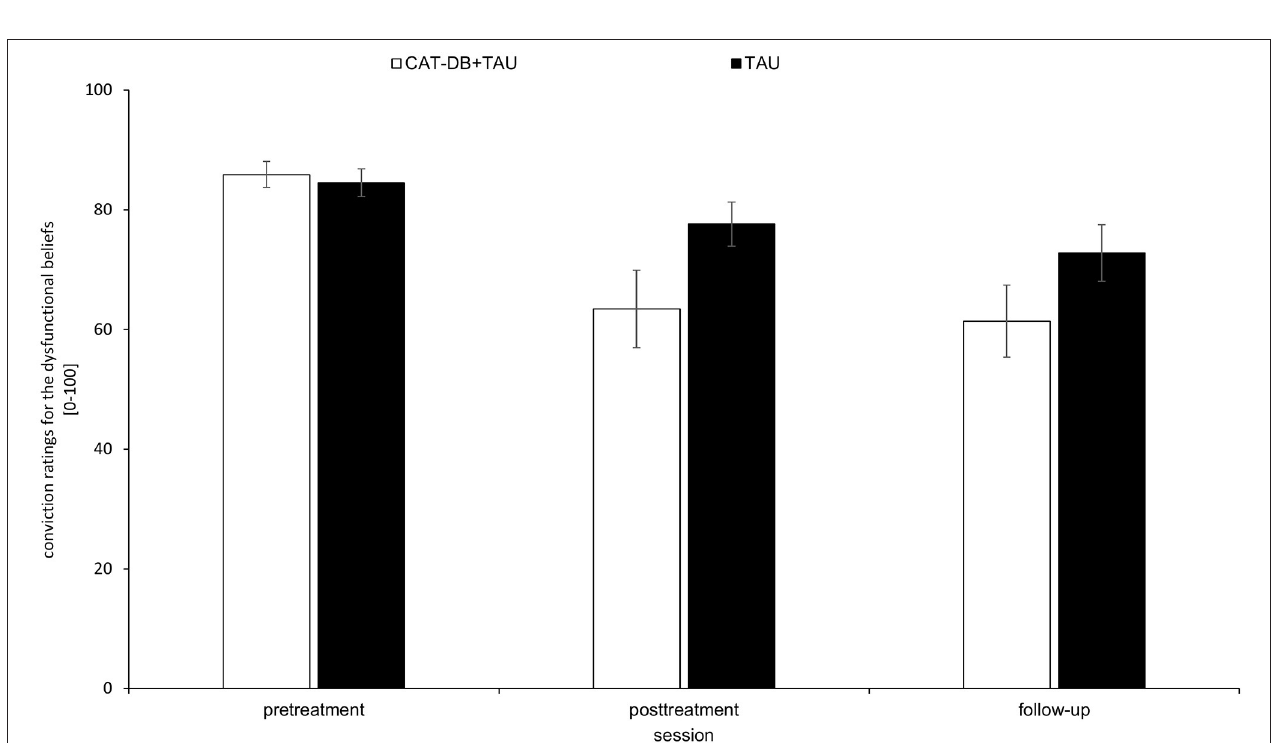
FIGURE 3 | Mean score of the conviction ratings for the dysfunctional beliefs in the CAT-DB + TAU group ( n = 16) and the TAU group ( n = 14) at pre-treatment, at post-treatment and at follow-up. Error bars represent standard errors.